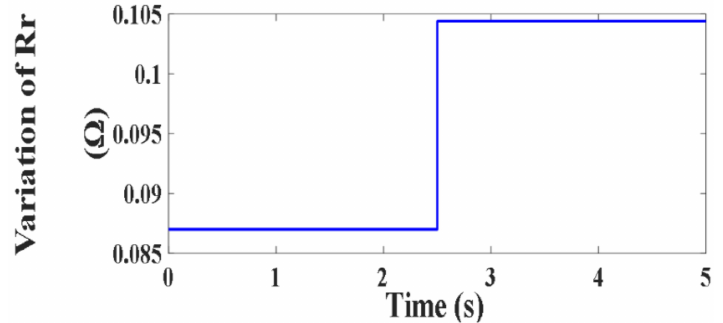
Figure 84. Variation of R r ( Ω ).